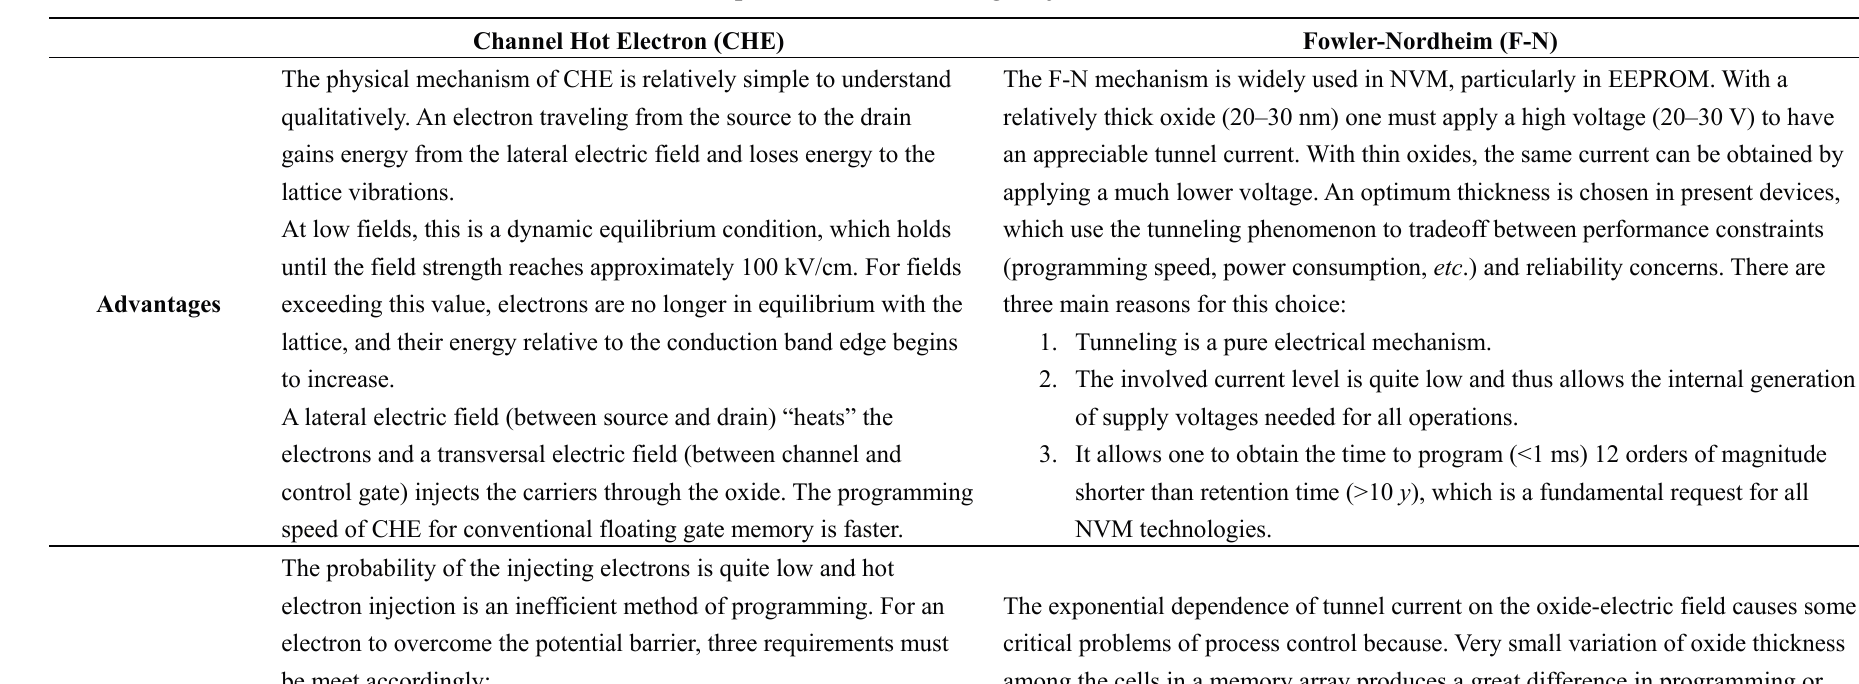
Table 4. Comparison between charge injection mechanisms